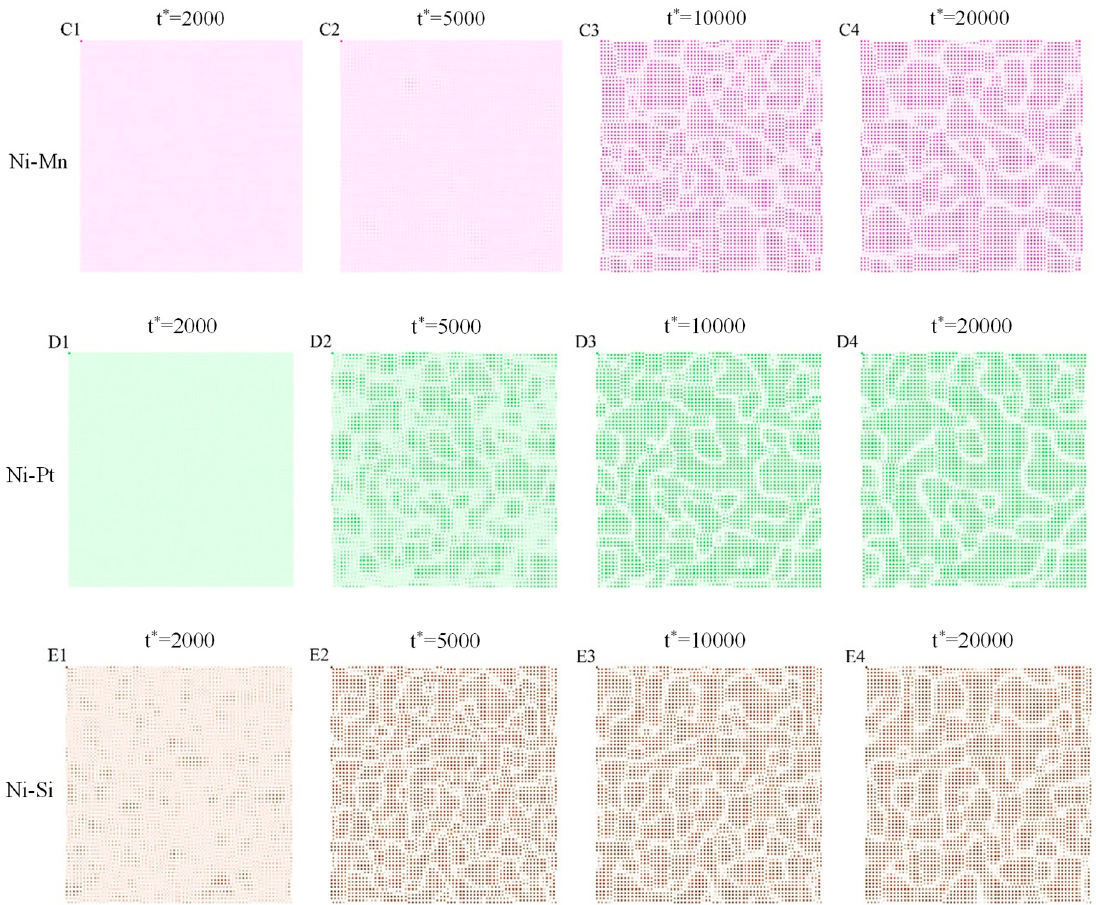
Figure 4. Microstructural evolution at simulation time t* = 2000, 5000, 10,000, and 20,000 for: Ni–Al at 1574 K ( A1 – A4 ); Ni–Fe at 686 K ( B1 – B4 ); Ni–Mn at 618 K ( C1 – C4 ); Ni–Pt at 638 K ( D1 – D4 ); Ni–Si at 1162 K ( E1 – E4 ).